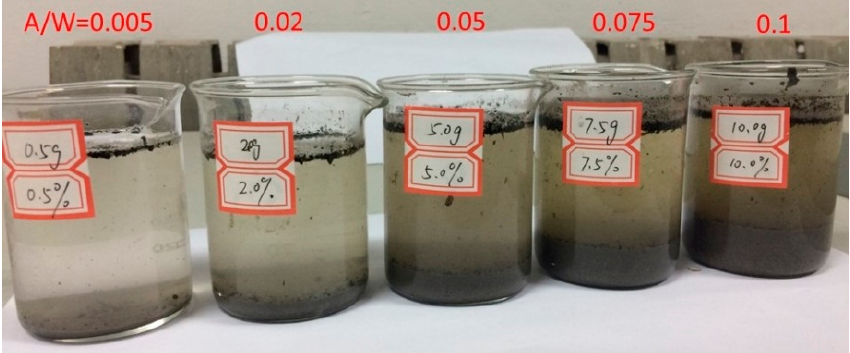
Figure 1. Plant ash lixivium suspensions with different ash-to-water (A/W) ratios.